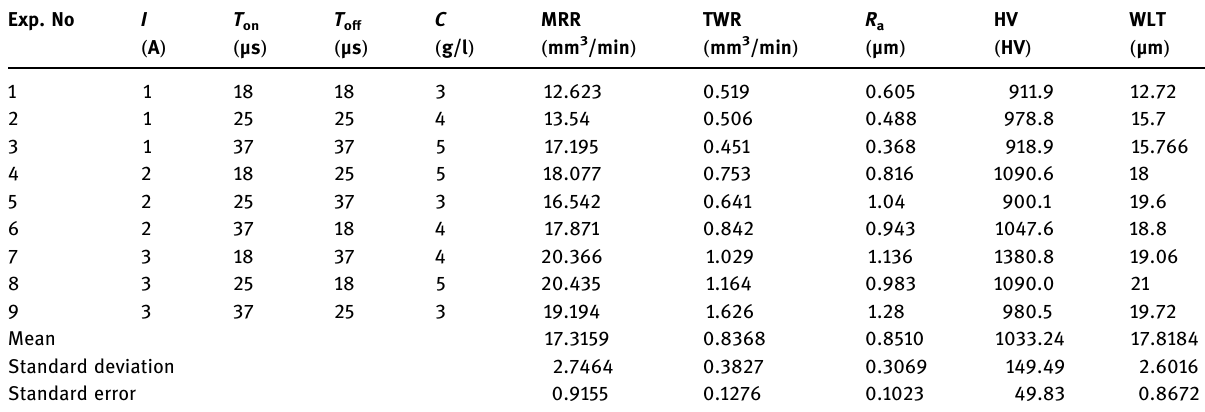
Table 2: Quality measures matrix in PMEDM process Exp.